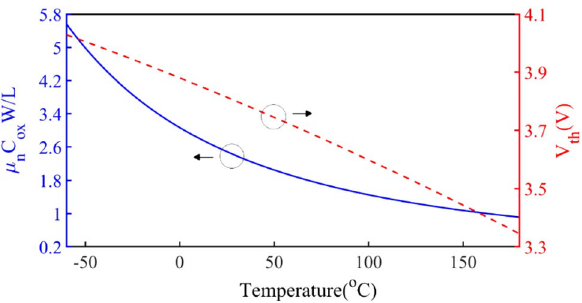
Figure 4. The dependence of V th and mobility as a function of temperature for the IRF510 transistor.